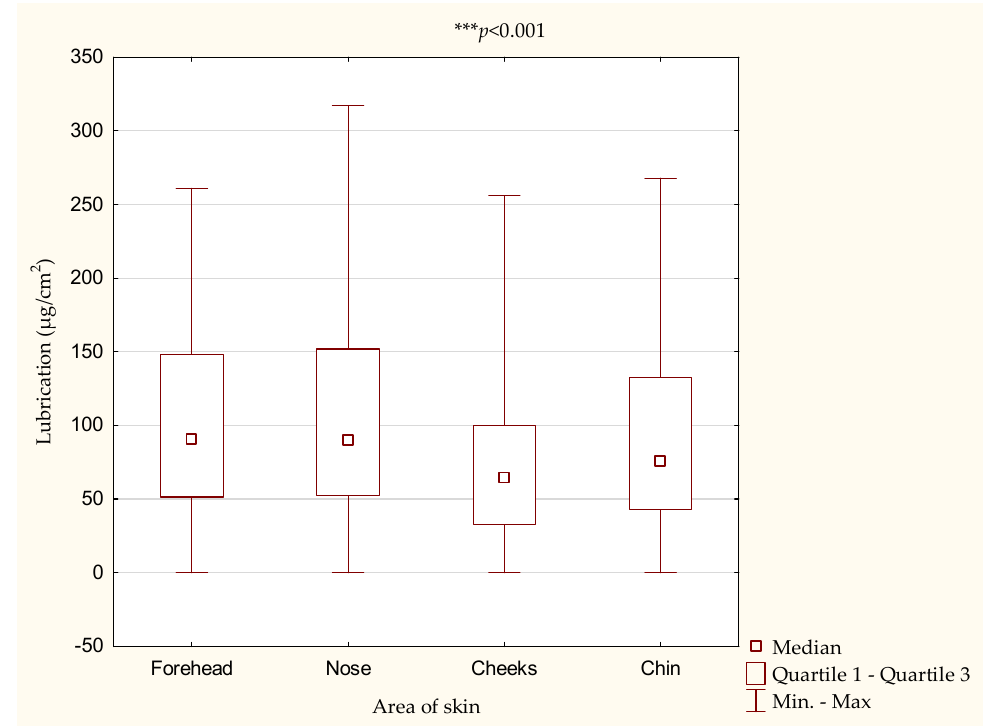
Figure 2. Differences in lubrication of the body and face skin. Av.—average, SD—standard devia- tion.